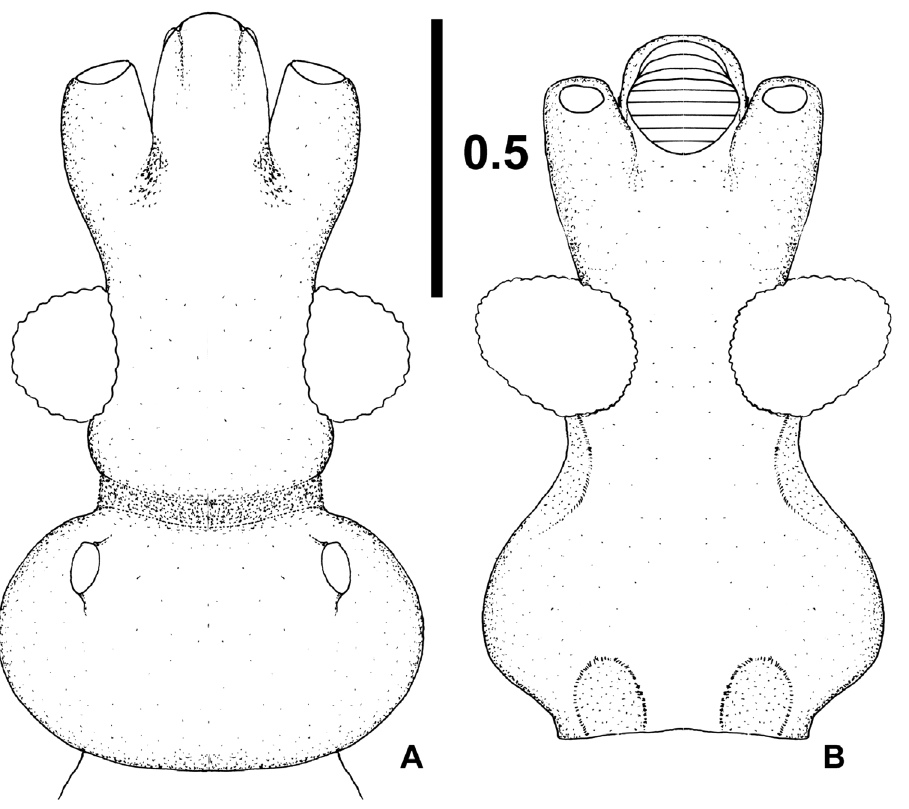
Figure 5. Xenicocephalus tomhenryi sp. n., female holotype, head A dorsal view B ventral view. Scale bar in